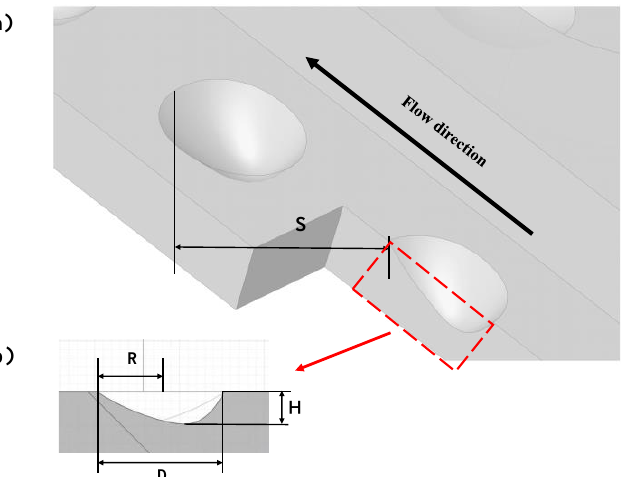
Figure 2 . ( a ) BFS notch profile ( b ) Schematic diagram of the flow path of the liquid cooling plate with the BFS structure.